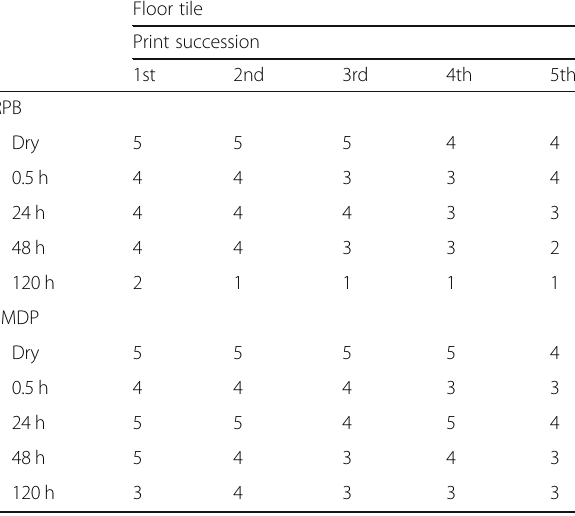
Table 3 Development of submerged and successive prints on floor tile using Robin powder blue and silver magnetic dual